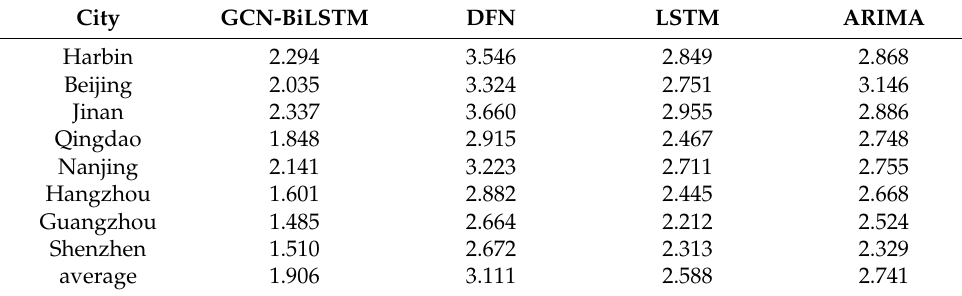
Table 8. Comparison of RMSE for multiregional temperature prediction.